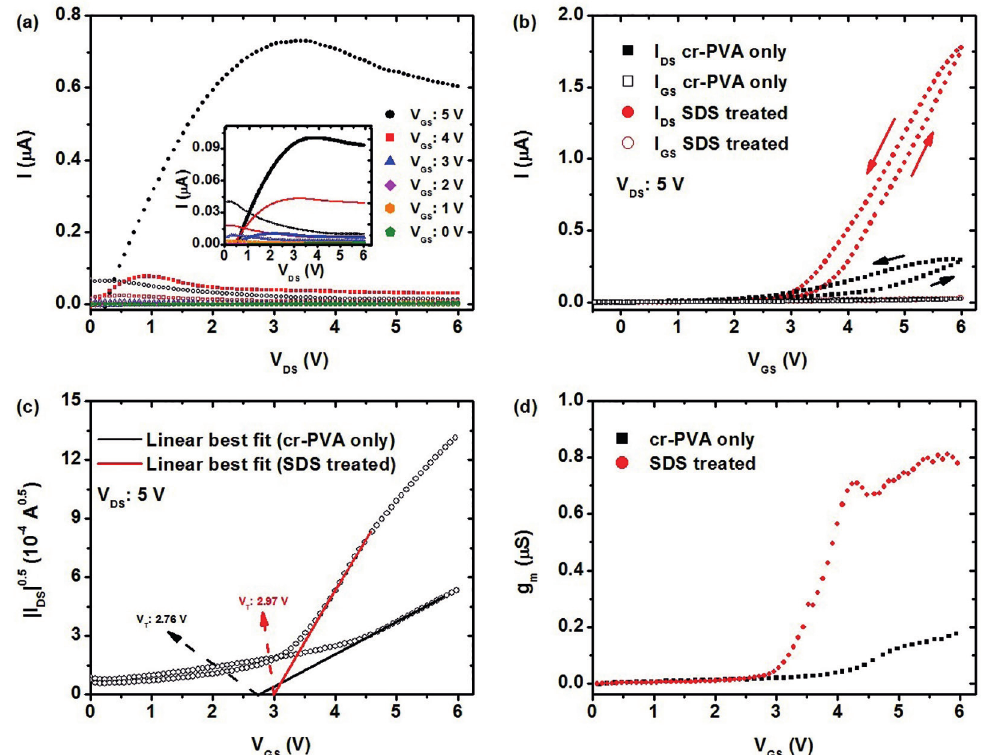
(V )) of SDS treated device (inset shows I DS D S ( V )); (c) linear best-fit plots for mobility and V DS GS ) as a function of V m